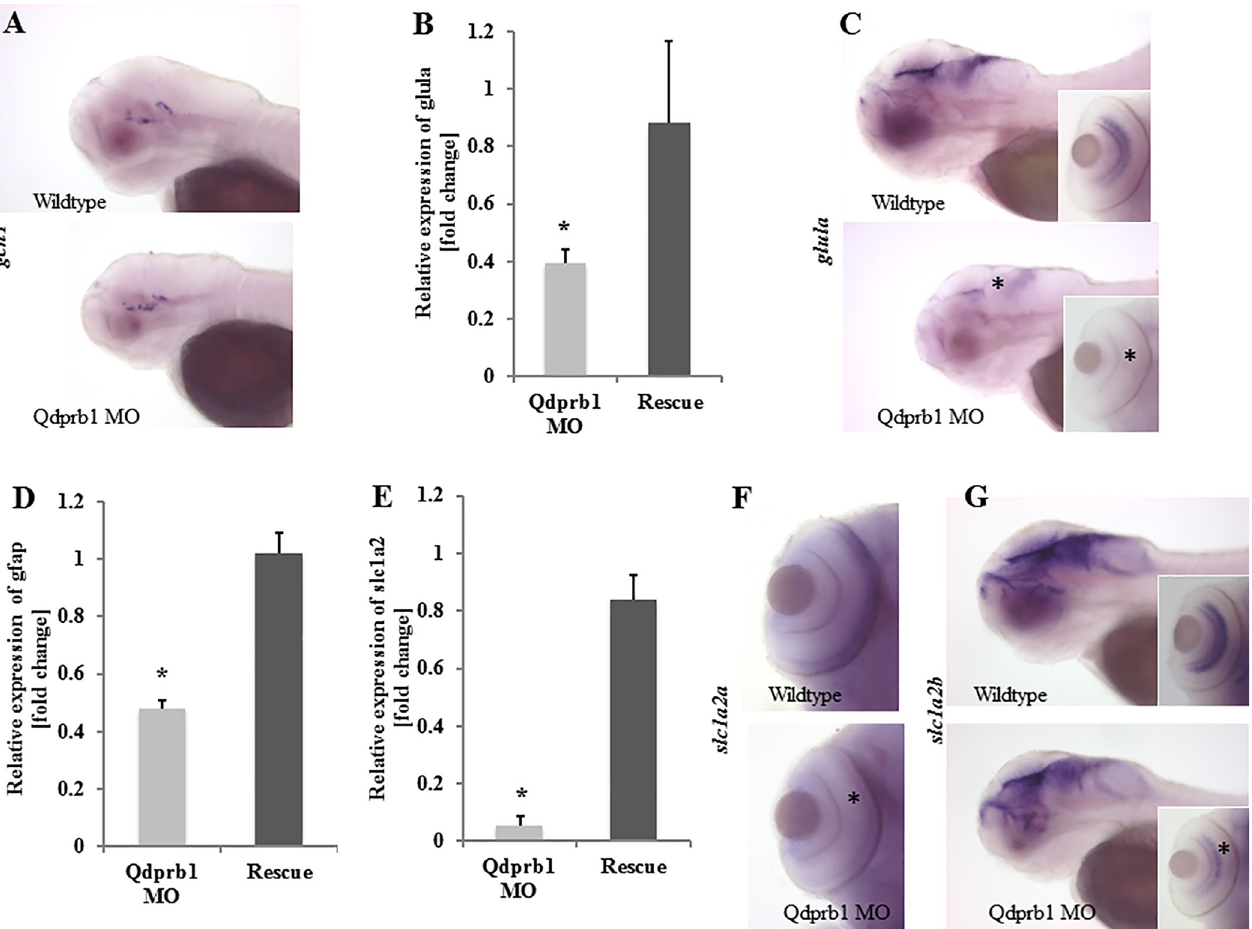
Fig 5. Expression of astroglial markers at 72hpf. (A) Lateral views with anterior to the left. WISH of the BH 4 de novo synthesis pathway initiator and dopaminergic neuron marker, gch1 , shows unchanged staining upon qdprb1 knockdown. (B) RT-qPCR analysis reveals strongly reduced expression of g lula in qdprb1 hypomorphic embryos, which is rescued by qdprb1 mRNA co-injection. (C) Lateral views with anterior to the left. This finding is corroborated by WISH experiments highlighting that glula expression is lost in the eye (asterisk in inset) and reduced in the mid/hindbrain (asterisk). (D) Also g fap expression is reduced by qdprb1 knockdown and can be rescued by qdprb1 mRNA co-injection. (E) RT-qPCR analysis of astrocytic glutamate transporters show an almost complete loss of slc1a2a , which is confirmed by WISH (F)–dorsal views focused on the eye. Asterisk indicates the effect on slc1a2a expression. Slc1a2a expression is normalized in qdprb1 mRNA co-injected embryos (E). (G) Lateral views with anterior to the left. WISH of s lc1a2b reveals mildly reduced staining in midbrain and eye (inset), confirming that both SLC1A2 homologues are affected in Qdprb1 hypomorphic embryos.